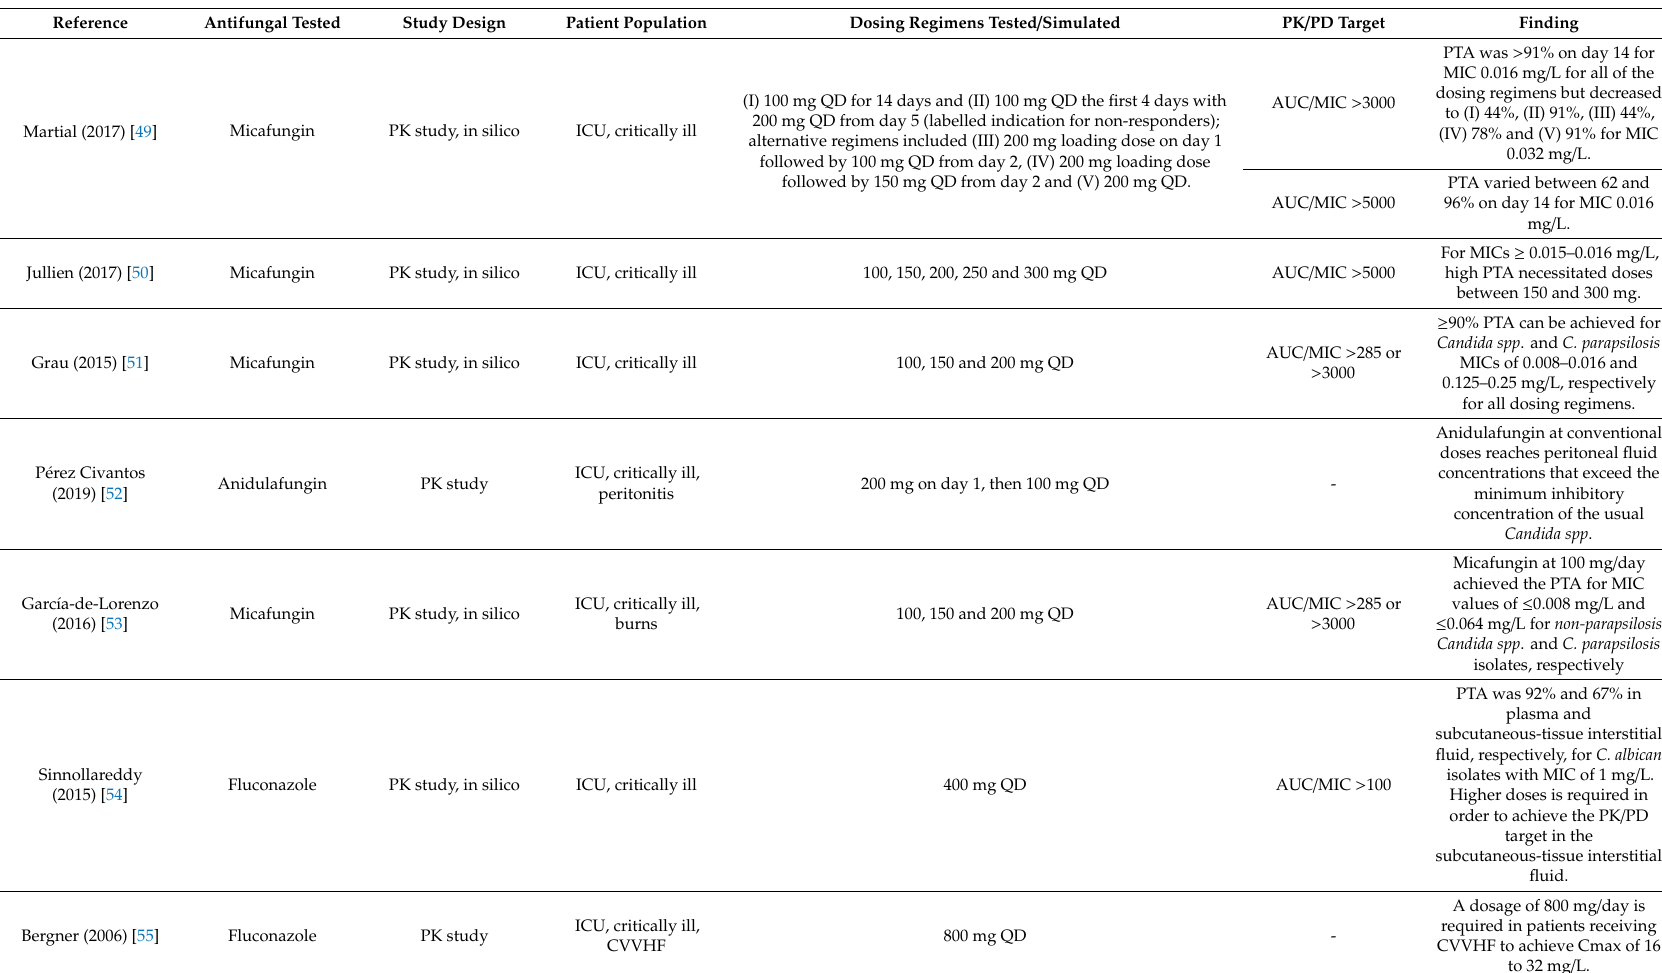
Table 1. PK / PD studies evaluating the dosing regimens of antifungals used for Candida sp.